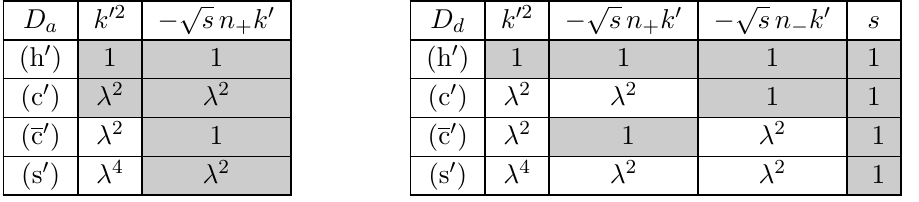
Table 3 . Scaling associated with the terms in the propagators D a and D d , as de(cid:12)ned in eq. (2.22). D c